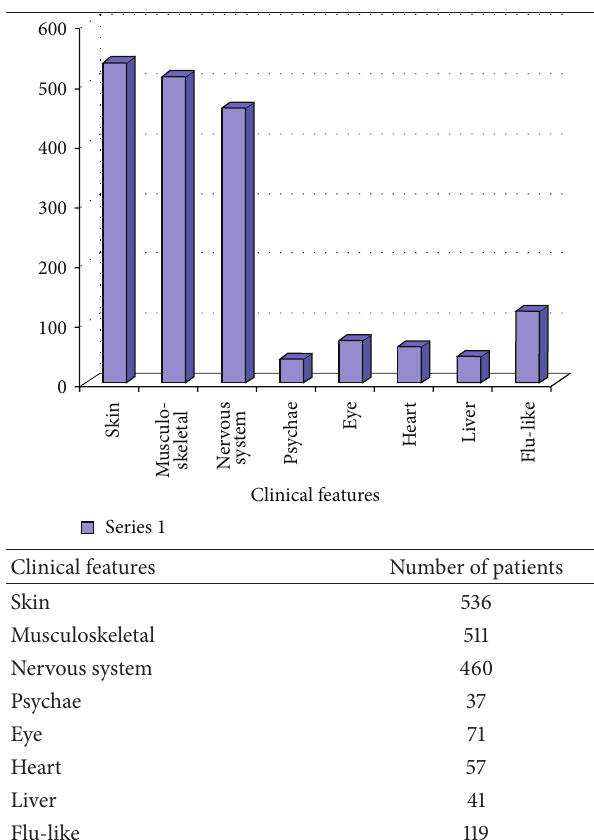
Table 1: The clinical manifestations observed in the 705 patients seropositive for Borrelia burgdorferi